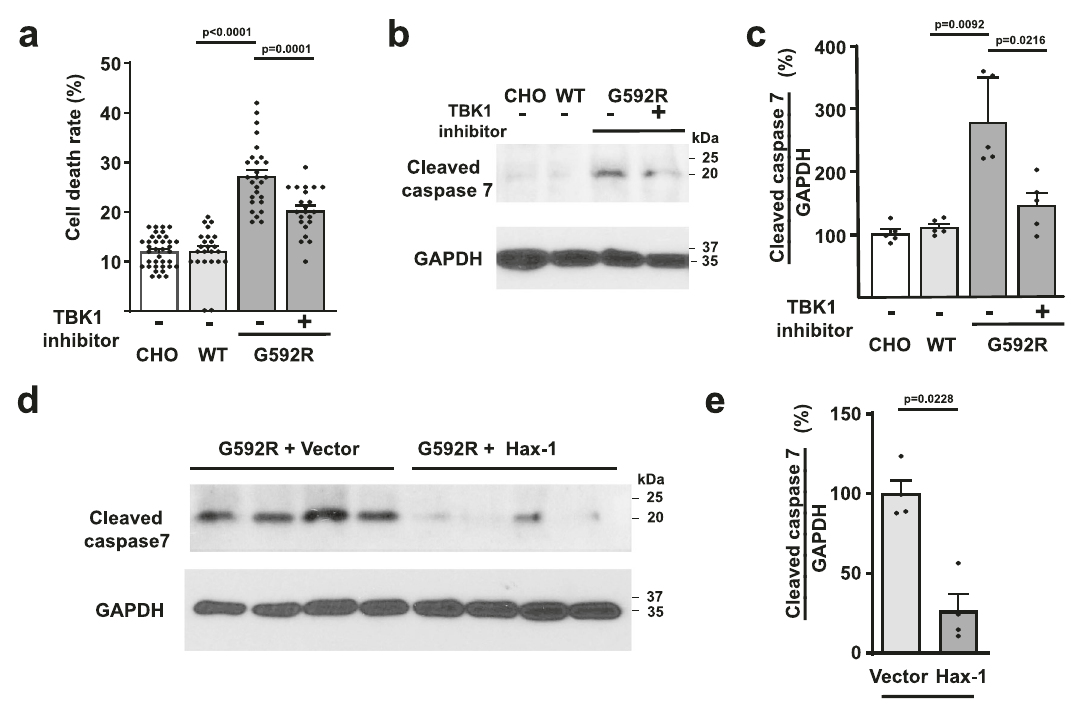
Fig. 6 Cell death is increased by G592R Kv3.3. a Quanti fi cation of propidium iodide staining in untransfected CHO cells and cells expressing wild type or G592R Kv3.3 channels ( n = 3 dishes; data are presented as mean ± SEM; two-tailed unpaired t test). b Western blots showing levels of cleaved caspase 7 experiments; data are presented as mean ± SEM; two-tailed paired t test). d Western blots showing the effect of overexpression of Hax-1 in G592R Kv3.3 cells on levels of cleaved caspase-7. e Group data for d ( n = 4 independent experiments; data are presented as mean ± SEM, two-tailed paired t test). Source data and uncropped Western blots are provided as a Source Data fi